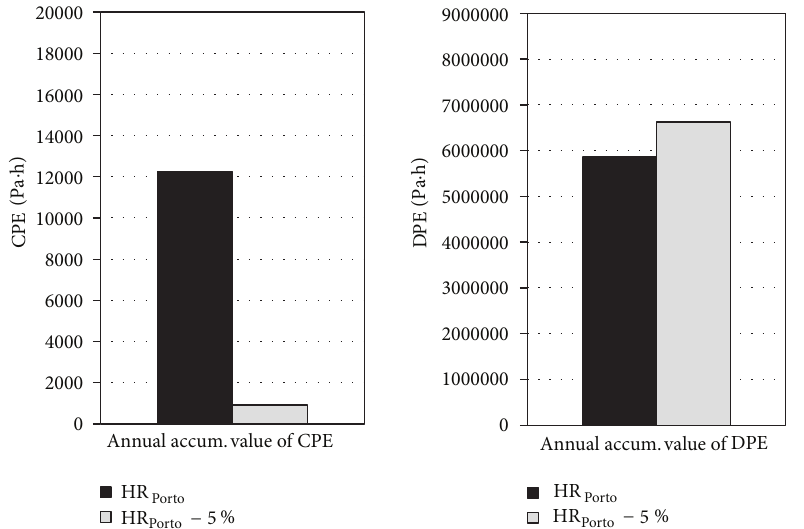
Figure 17: Exterior climate: relative humidity.